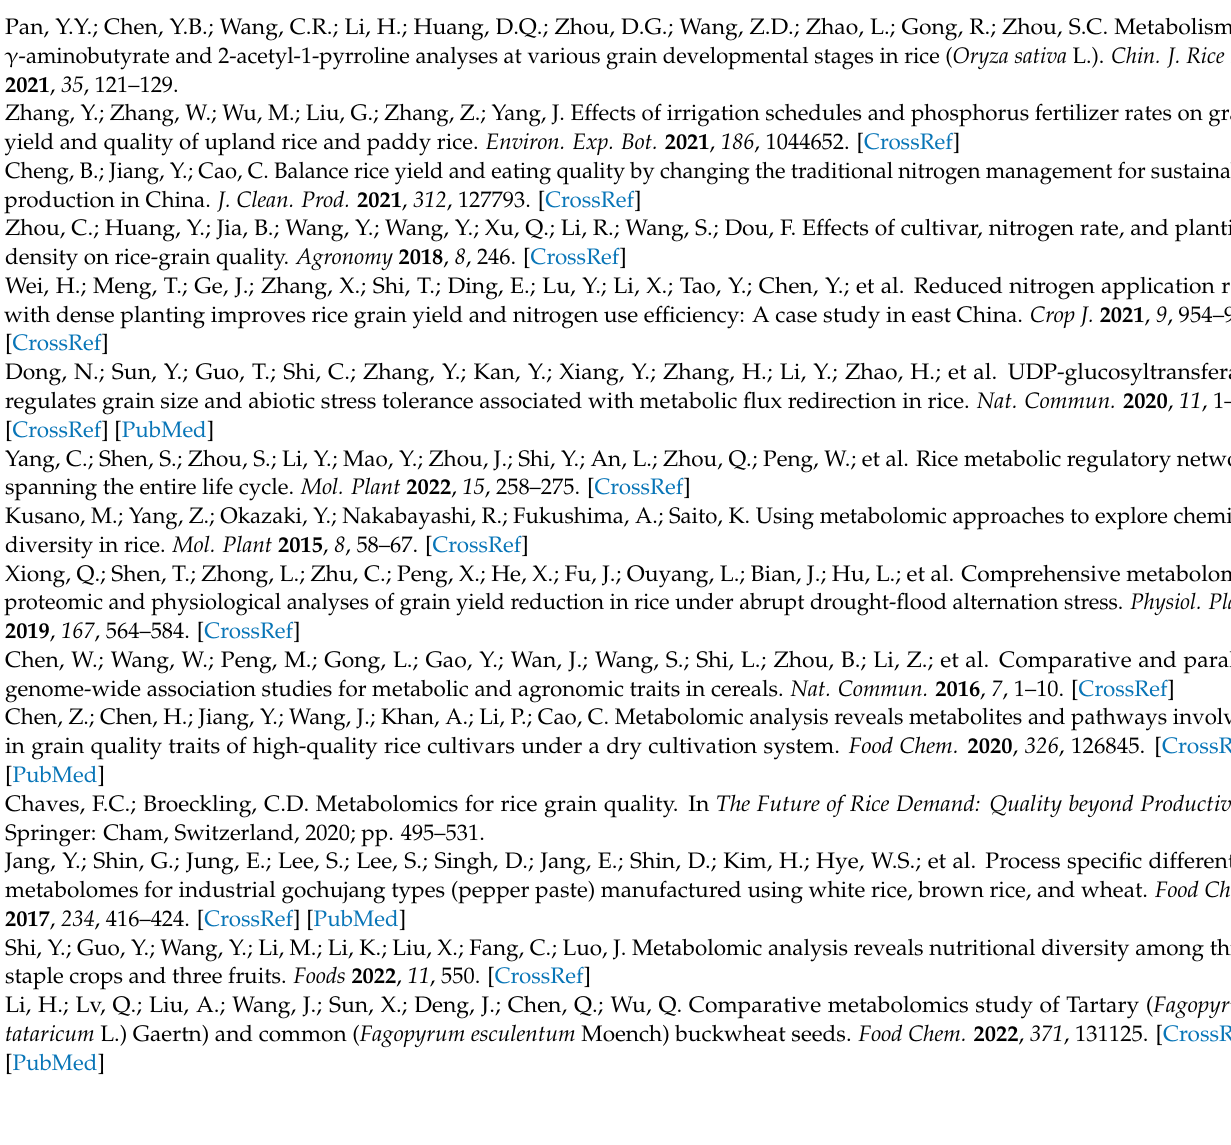
MNMD. Table S3: Differential metabolite information between LNHD and